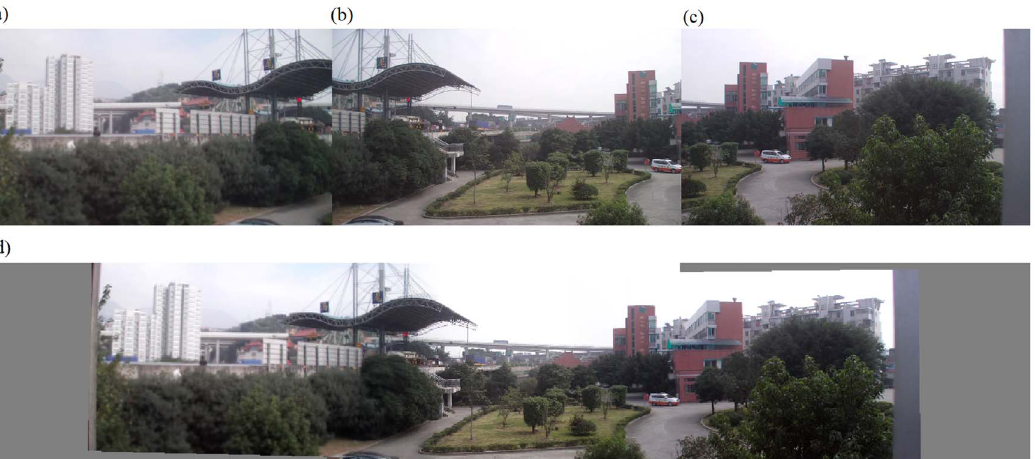
Figure 10. Experiments on the entire image-stitching algorithm (III): (a) Video image 1; (b) Video image 2 (reference image); (c) Video image 3; (d) Generated video panoramic image.